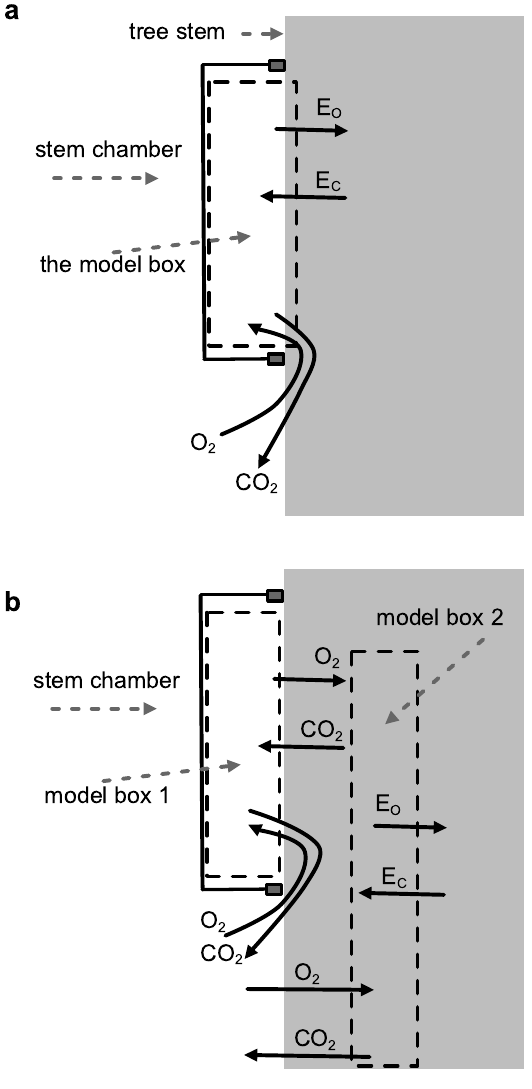
Fig. 1. Schematic drawing of the model boxes and fluxes: (a) 1-box model, (b) 2-box model. The O 2 and CO 2 diffusive fluxes, as well as the fluxes of O 2 consumption ( E O ) and CO 2 release ( E C ) are shown by solid